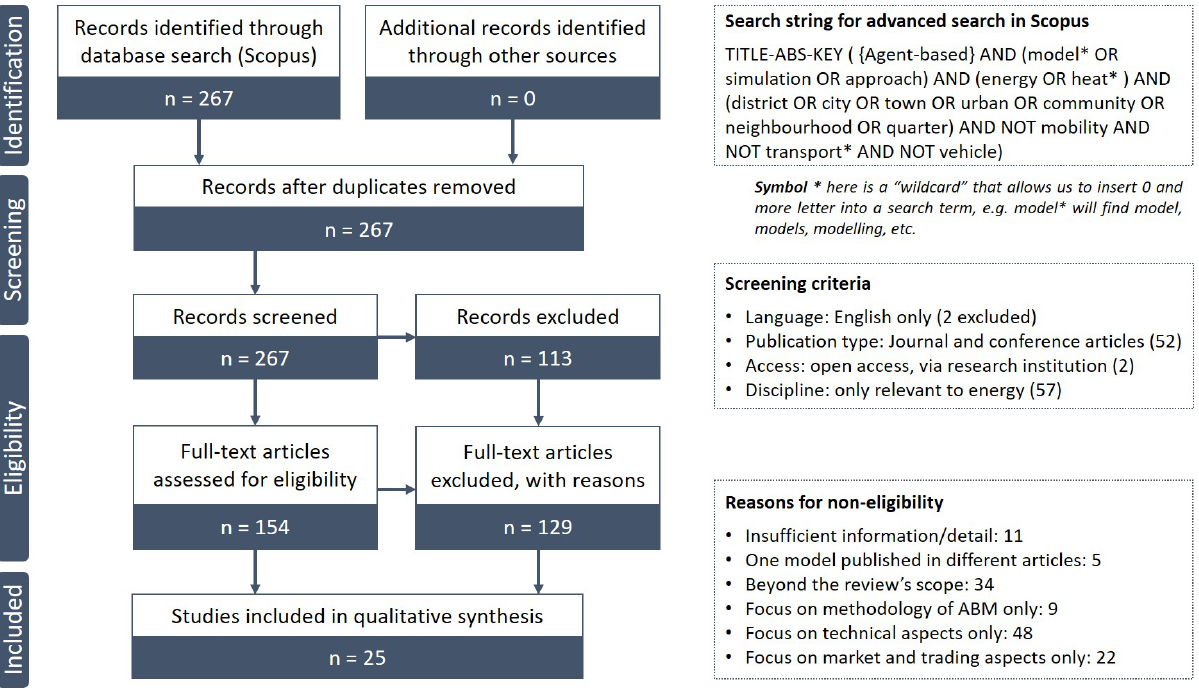
Figure 2. PRISMA Flow Diagram of study selection for reviewing ABM of urban district en- ergy